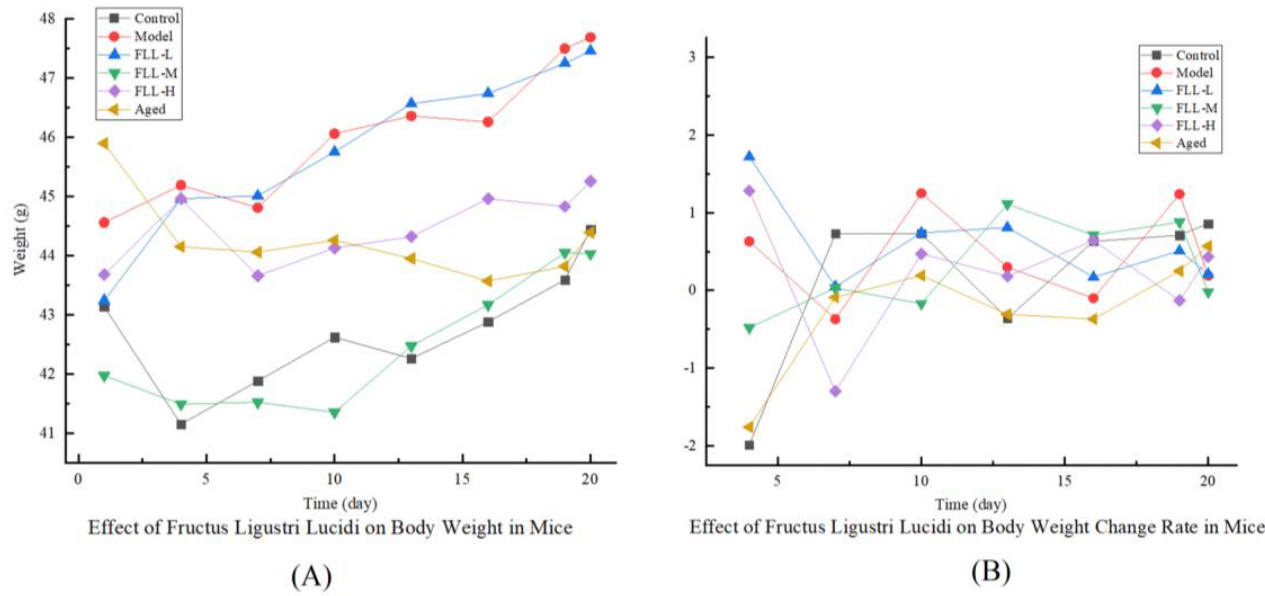
Figure 1. Effects of Fructus Ligustri Lucidi (FLL) on body weight ( A ) and weight change rate ( B ) in mice of each group. The body weight of the mice was monitored per three days throughout the study period. Weight change rate (%) = (last weight − initial weight)/initial weight × 100%.